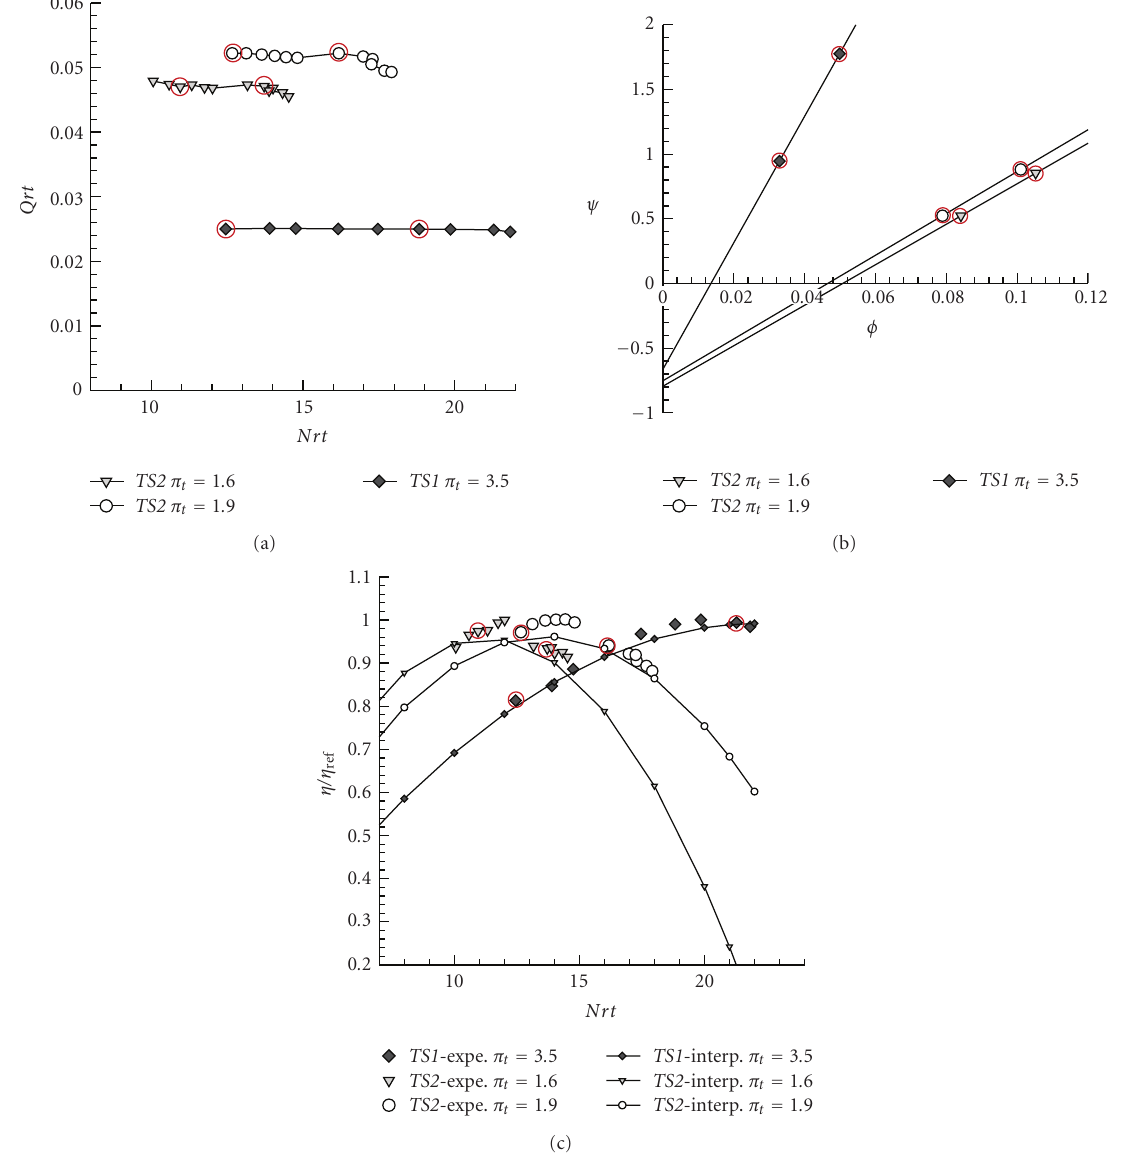
Figure 6: Interpolation process